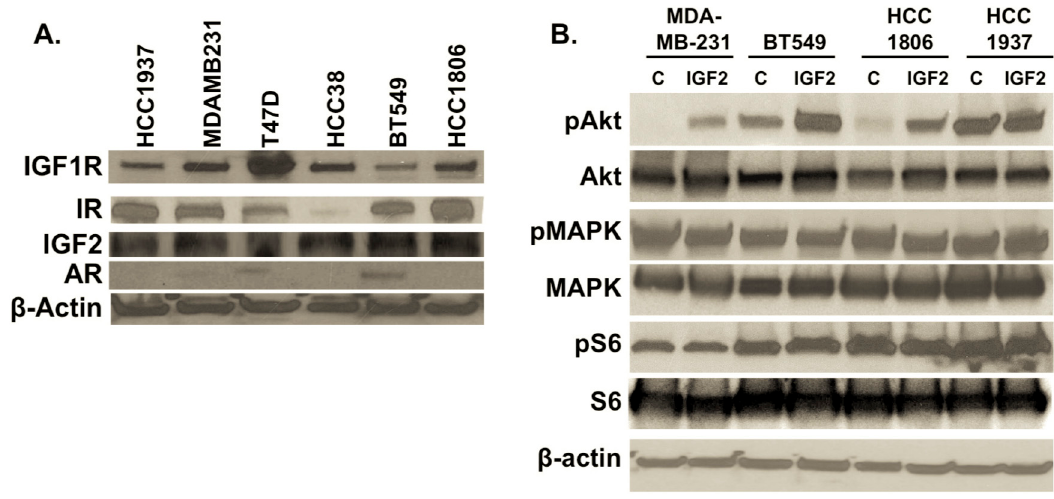
Figure 2. ( A ) Expression of IGF2, IGF1R, insulin receptor (IR) and androgen receptor (AR) in TNBC cultures. Total protein was isolated from cell cultures. Forty micrograms of protein were separated and transferred to PVDF membranes for detection of IGF1R (1:500, Cell Signaling #3027, Danvers, MA, USA), IR (1:500, Cell Signaling #3025), IGF2 (1:1000, AbCam ab9574), and AR (1:500, Cell Signaling #5153). β -actin (1:2000, Sigma #A1978, St. Louis, MO, USA) was used as a loading control. TNBC cells include HCC1937, MDA-MB-231, HCC38, BT549 and HCC1806, with ER α -/PR-positive T47D cell line as a control; ( B ) Effects of IGF2 treatment on downstream phosphorylation of MAPK, AKT and S6. IGF2-induced activation of IGF1R leads to increased phosphorylation of AKT in most TNBC cells assessed. TNBC cultures were treated with IGF2 (100 ng/mL) in serum- and phenol red-free media for 20 min. Total protein was isolated, separated and transferred to PVDF membranes. Detection of MAPK (1:1000; Cell Signaling #9102), pMAPK (Cell Signaling #4370), S6 (1:2000; Cell Signaling #2217), pS6 (Cell Signaling #4858), AKT (1:1000 Cell Signaling, #4685) and pAKT (Cell Signaling #4060) was accomplished following the manufacturer’s recommended protocols (Methods). C = control vehicle-treated cells. IGF2 = cells treated with IGF2 for 20 min. Western immunoblots are representative of three independent experiments.